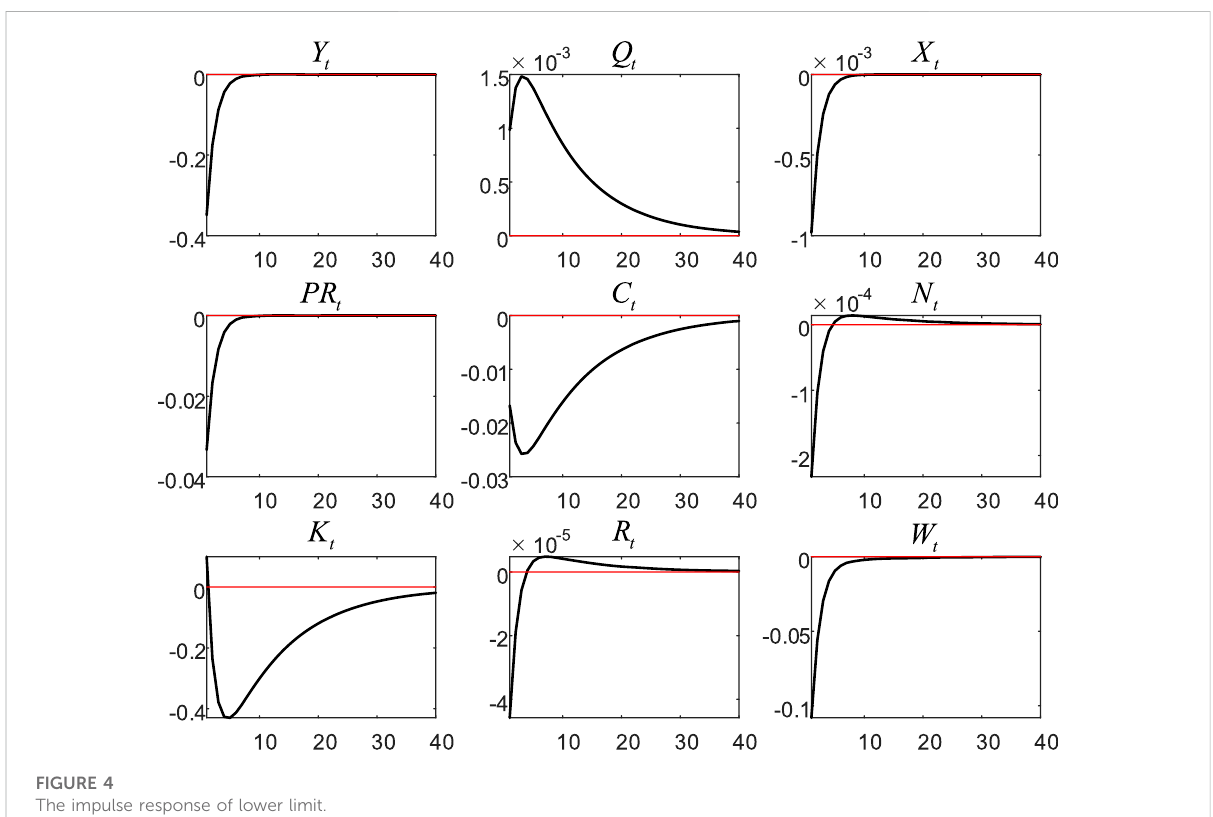
FIGURE 4 The impulse response of lower